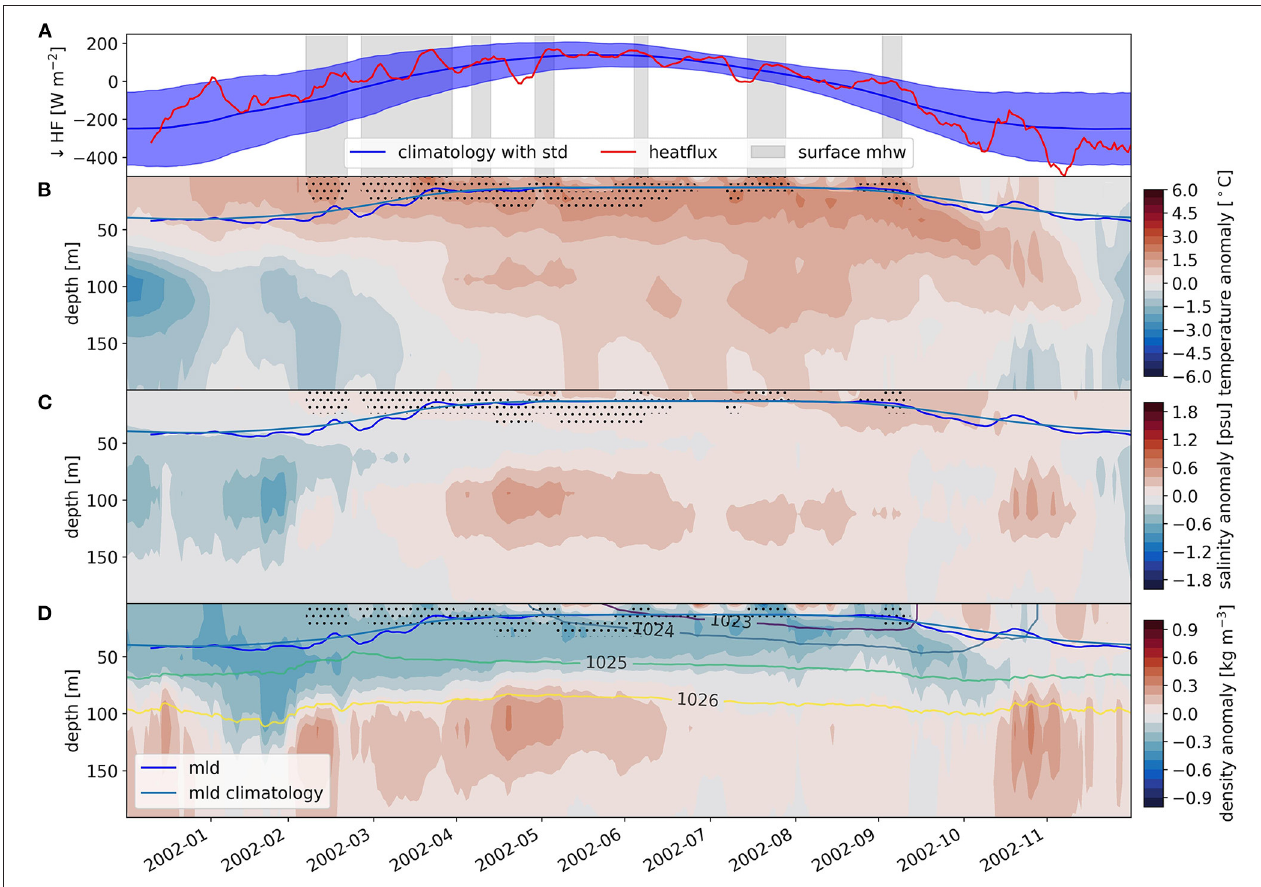
FIGURE 11 | 2002 MHW characteristics; time series of net downward surface heat flux (A) and hovmoeller plots for temperature (B) , salinity (C) , and density (D) anomalies with depth over time for 2002; (A) contains the heat flux from the current year and the heat flux climatological values; light and dark blue line (B–D) show mixed layer depth from climatology and in 2002; labeled contour lines in (D) show absolute densities, stippling indicates MHW state; 10 day rolling window for heatflux and mixed layer depth time series. Values displayed represent an average over the shelf (ecoboxes, see Figure 1